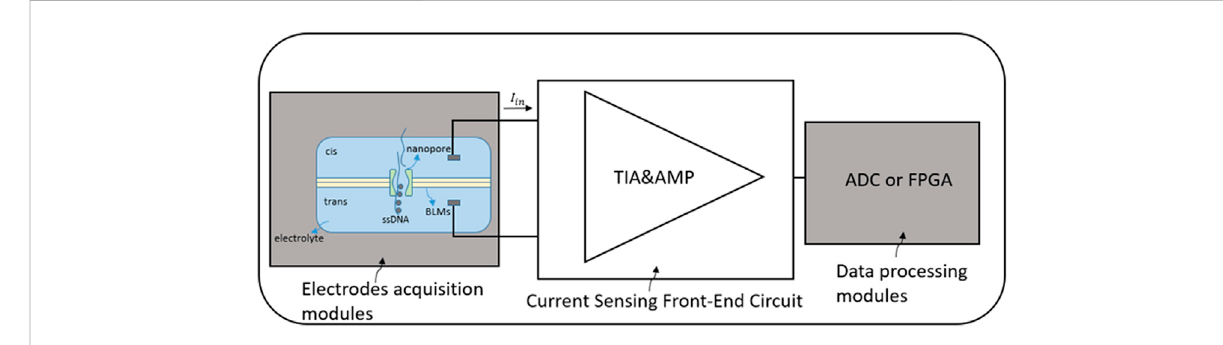
FIGURE 3 Block diagram of the nanopore-based DNA sequencing